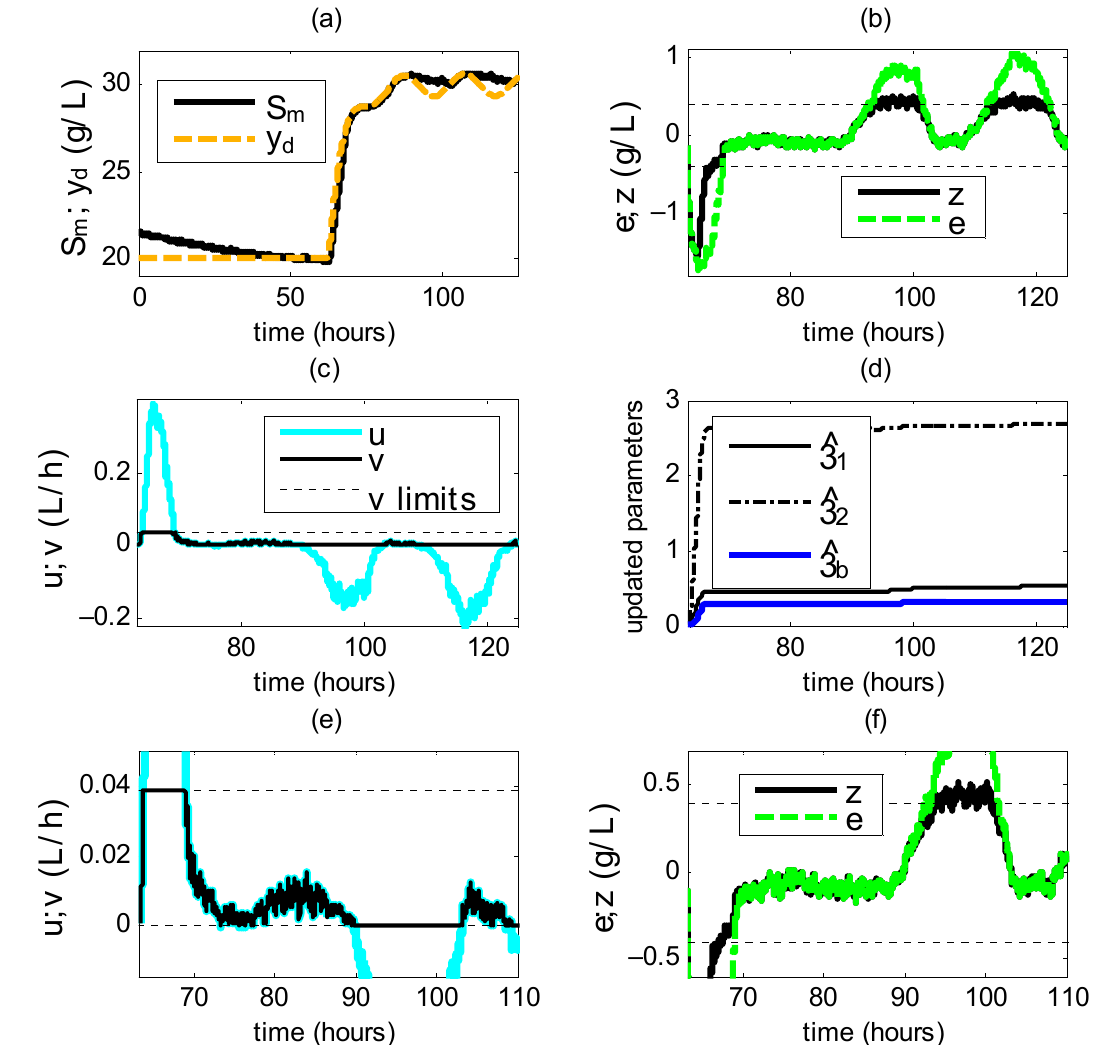
Figure 2. Simulation results for second case of reference model and controller parameter values. ( a ) Time course of the measured output S m and the desired output y d . ( b ) Time course of the tracking error e and the modified error z . ( c ) Time course of the non-saturated input u and the saturated input υ . ( d ) Time course of the updated parameters ˆ θ 1 , ˆ θ 2 , ˆ θ b . ( e ) Detail of non-saturated input u and the saturated input υ . ( f ) Detail of the tracking error e and the modified error z .